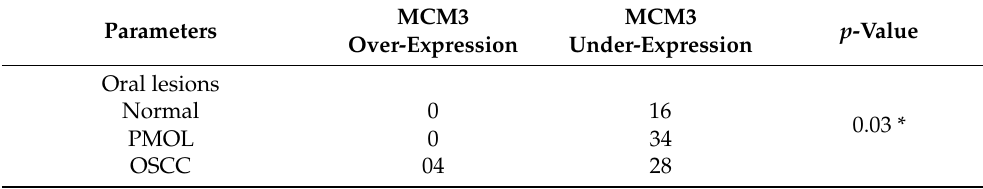
Table 5. MCM3 expression correlation with clinicopathologic parameters at 40% strong positive cells